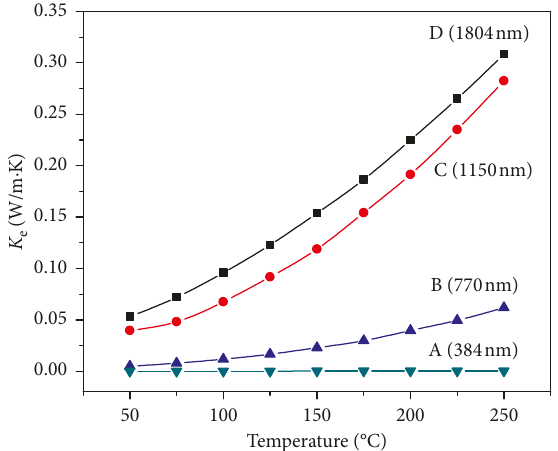
Figure 7: Electronic thermal conductivity of Sb function of measuring temperature.